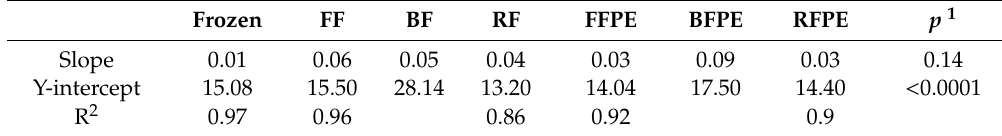
Table 6. Results of the regression analysis for mt-CO1 amplification by RT-qPCR.